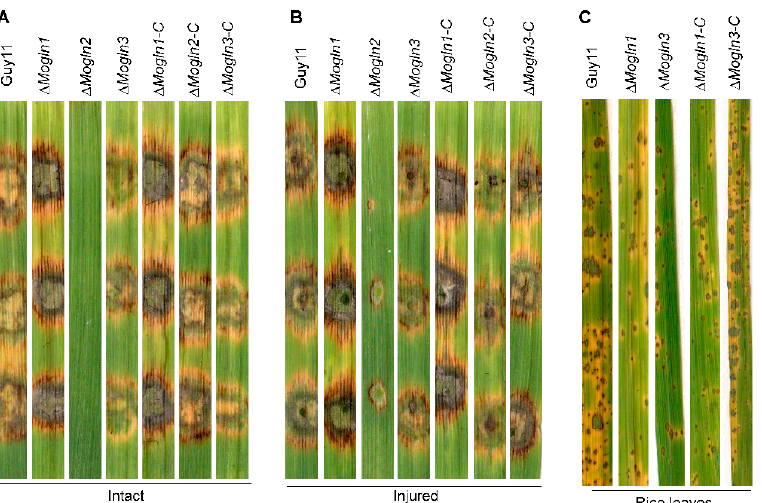
Figure 8. MoGLN2 plays an important role in promoting the infections of M. oryzae . ( A , B ) Δ Mogln2 failed to induce hyphae-mediated blast lesions on intact and injured barley leaves. ( C ) Rice leaves bearing blast lesions of Δ Mogln1 and Δ Mogln3 mutant spores. Both barley and rice leaf images were taken seven days post inoculation.